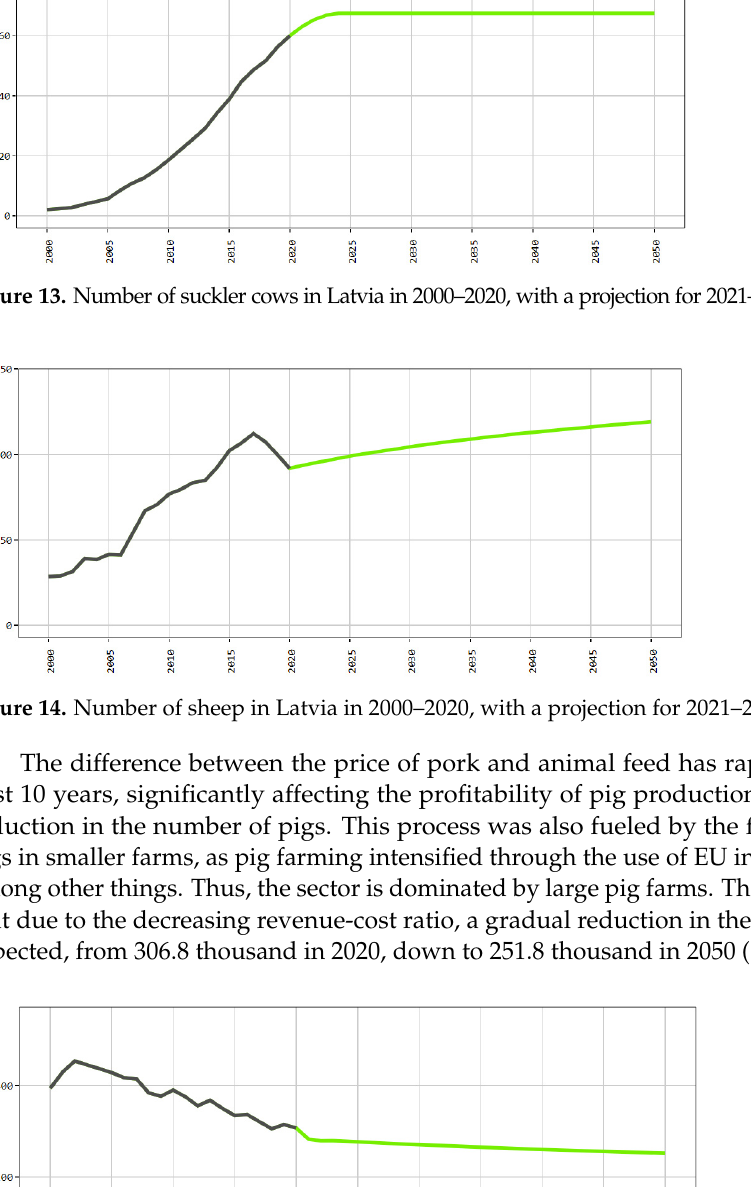
Figure 15. Number of swine in Latvia in 2000–2020, with a projection for 2021–2050, thousands [62].